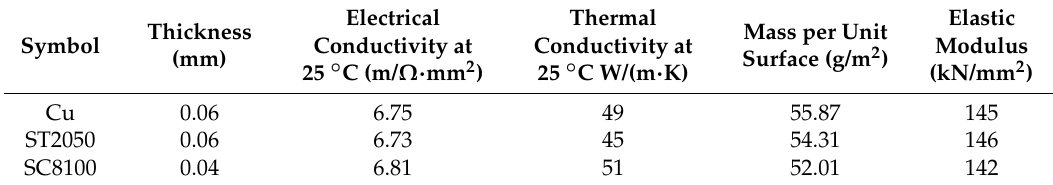
Table 1. Properties of the Cu and Ni in the proposed conductive cloth.